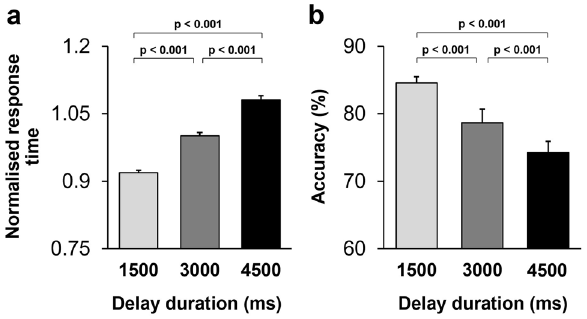
Figure 3. Monkeys’ performance was modulated by the delay duration. ( a ) Mean normalised response time is shown for each delay duration. Monkeys’ response time increased as the working memory load (delay duration) increased. ( b ) Mean accuracy is shown for the three delay durations. Monkeys’ accuracy decreased as the working memory load (delay duration)